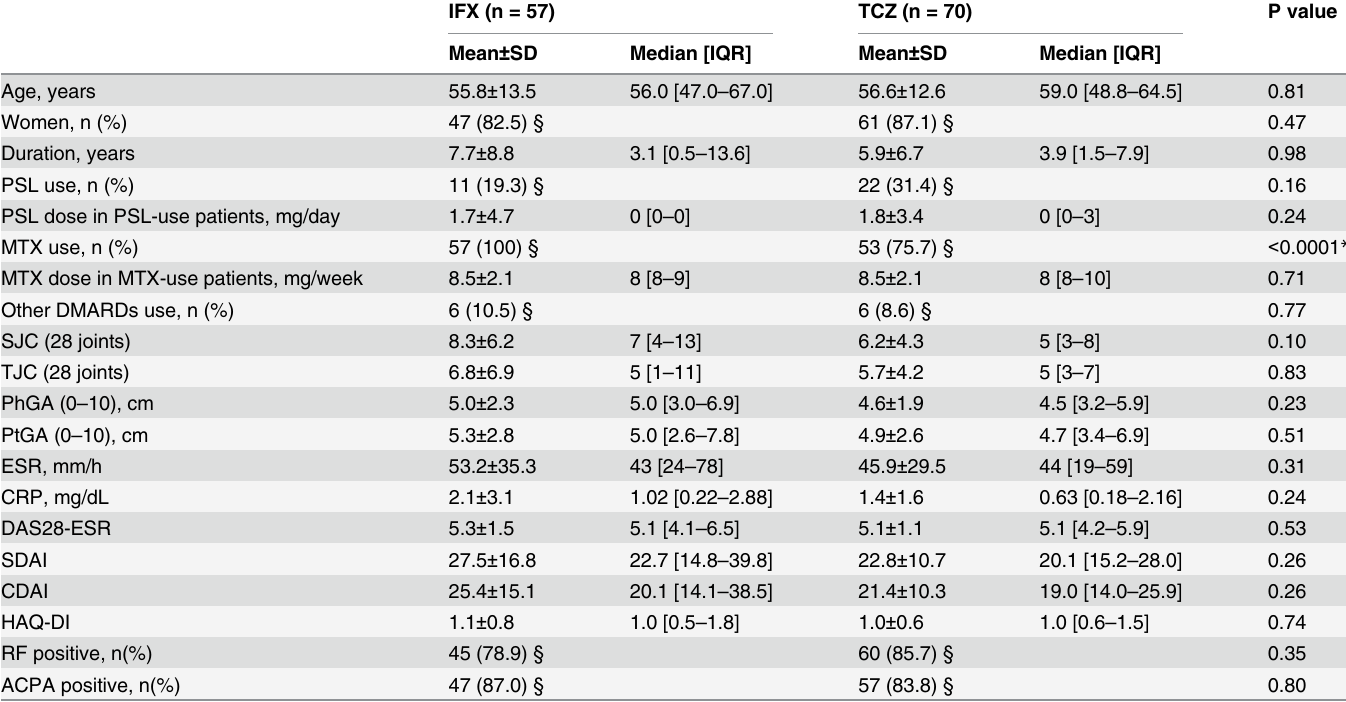
Table 1. Overall baseline characteristics of the patients.